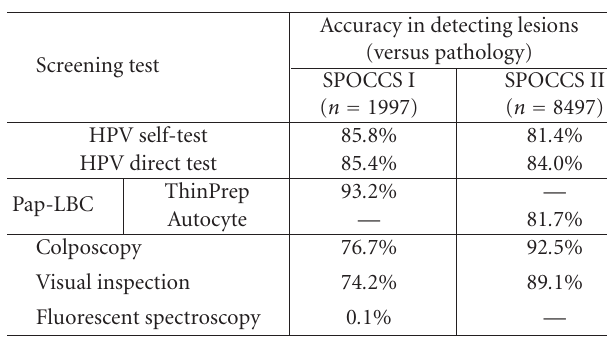
Table 4: Accuracy of screening tests for CIN 2+ compared with pathology.